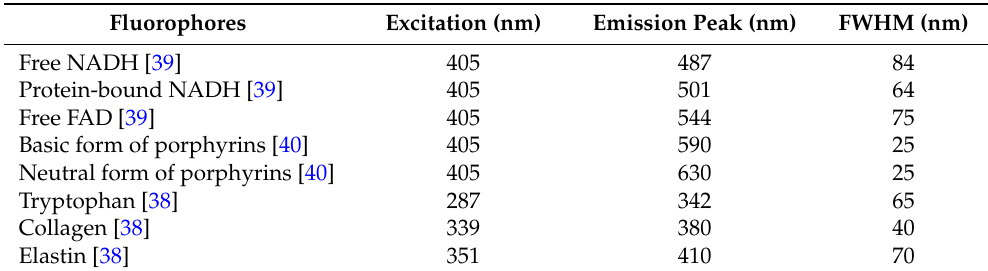
Table 1. The fitting parameters are reported as excitation wavelength, emission peak, and full width at half maximum (FWHM) of different fluorophores [38–40].